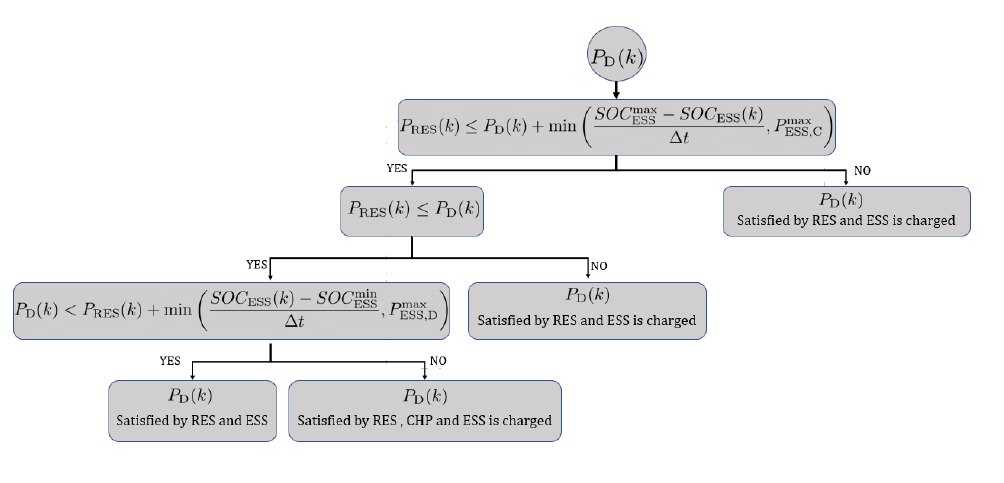
Figure 5. Electrical demand satisfaction